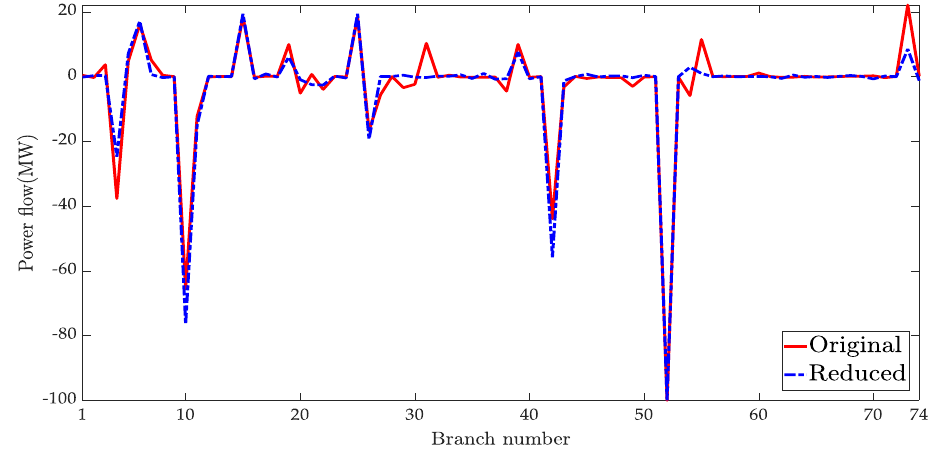
Figure 7. Variation in transmission line power flows with 100 MW injection into bus 3.